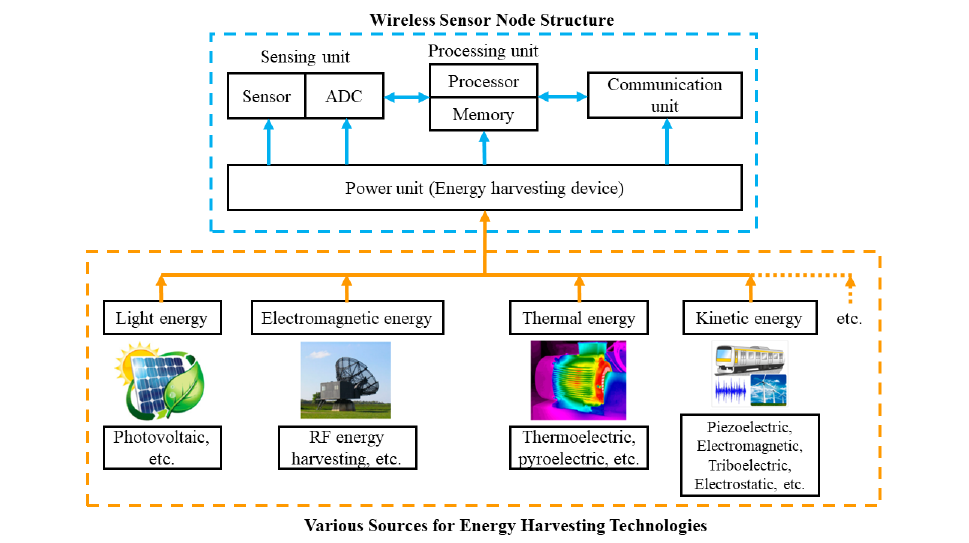
Figure 7. Sources for energy harvesting (adapted from [53]) (the blue line encompasses the WSN structure, and orange line indicates various sources used for energy harvesting).